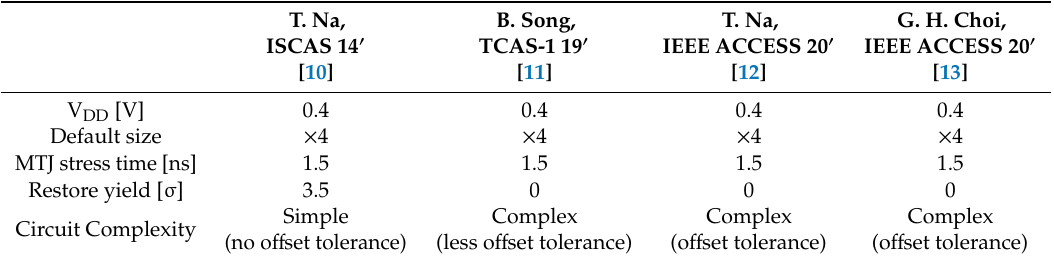
Table 2. Performance summary and comparison between the four state-of-the-art NVFFs [10–13] in case of V DD of 0.4